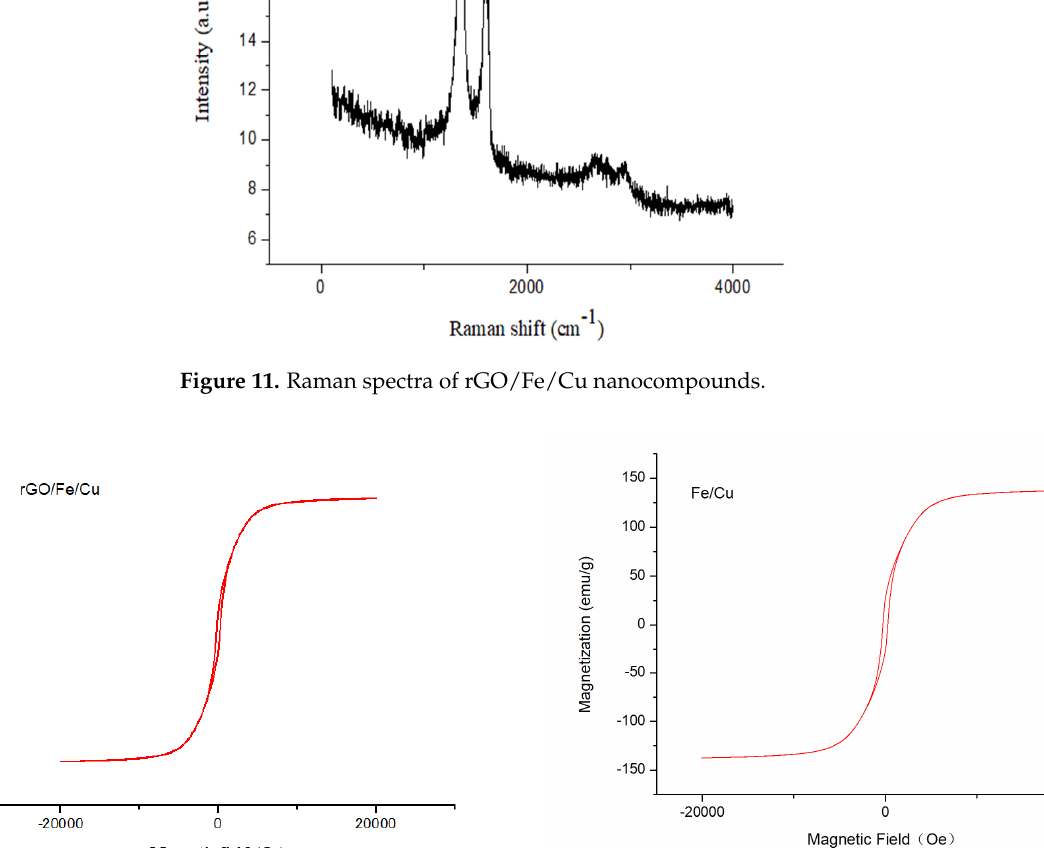
Figure 12. Magnetization hysteresis loop of the ( a ) Fe/Cu nanoparticles and ( b ) rGO/Fe/Cu nanocompounds at room temperature.